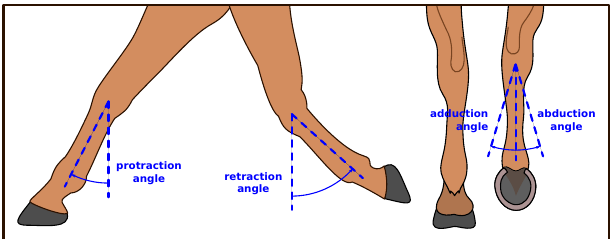
Figure 3. Forelimb protraction and retraction angles, and hindlimb adduction and abduction angles.